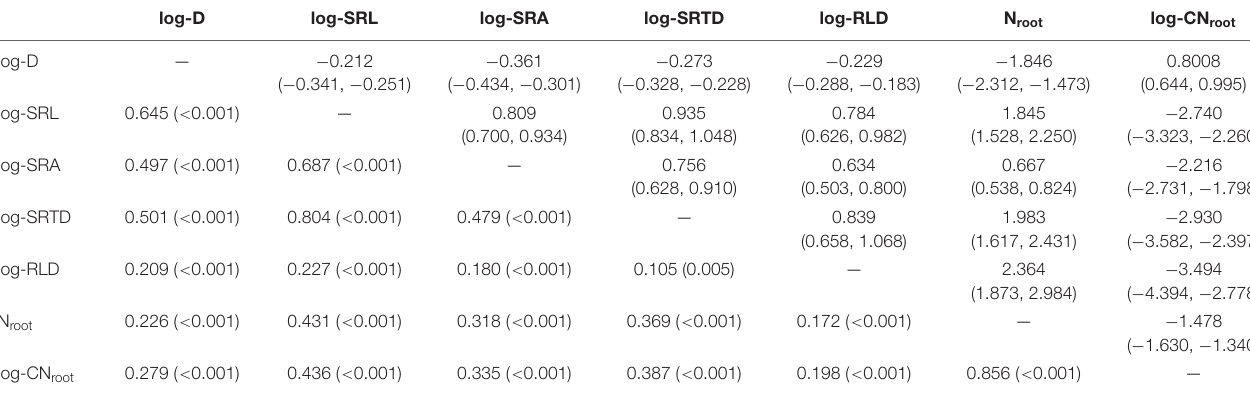
TABLE 3 | Bivariate relationships among seven root traits in C . arabica .